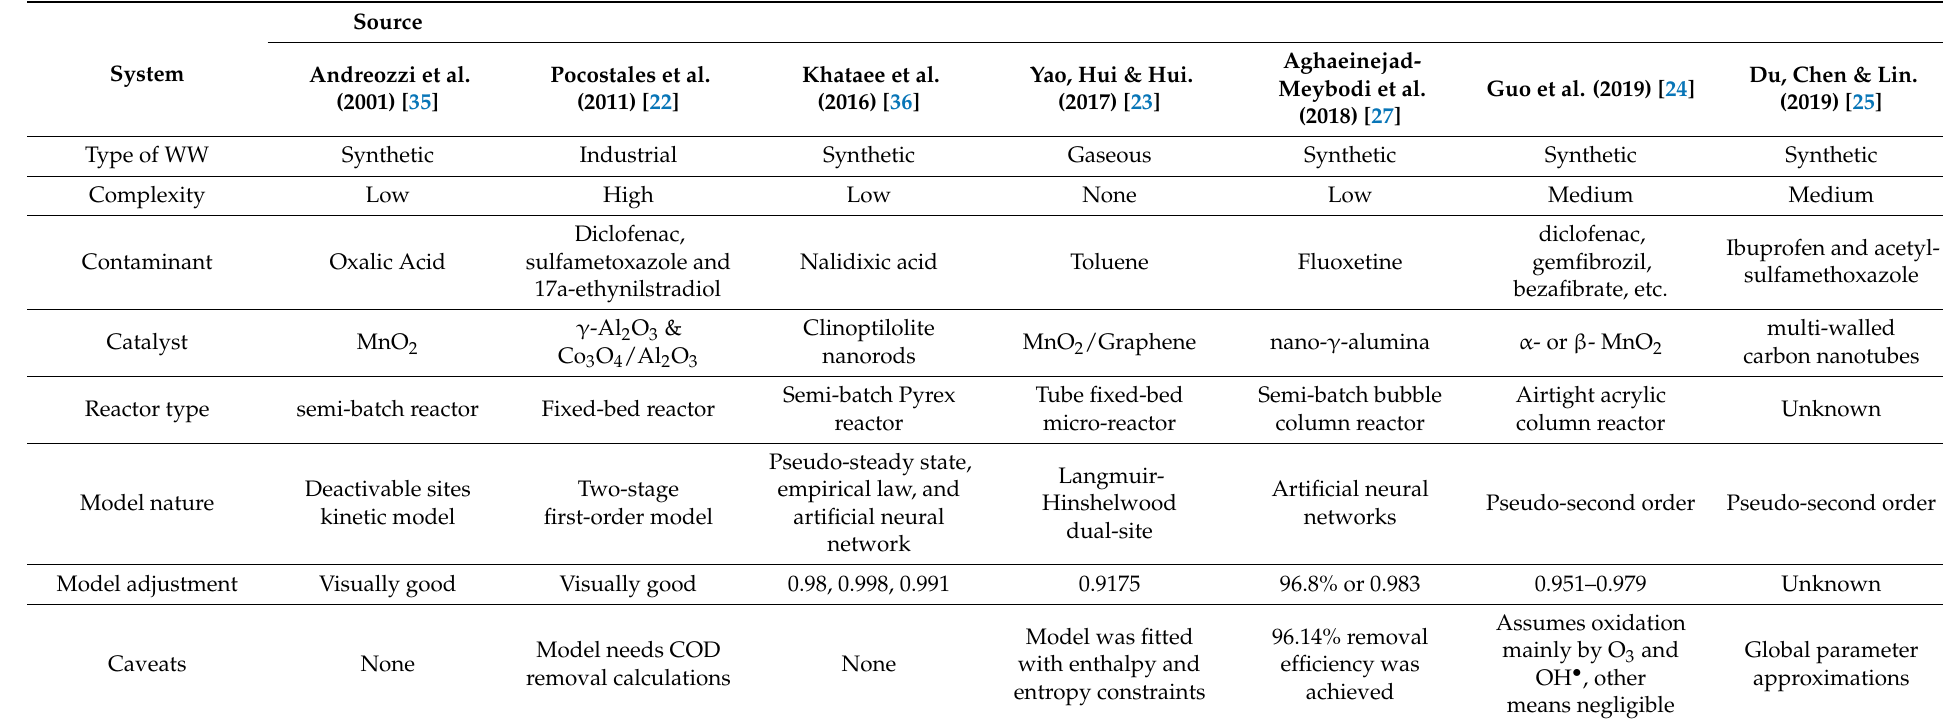
Table 1. Recent works are relevant to catalytic ozonation with FeOOH of